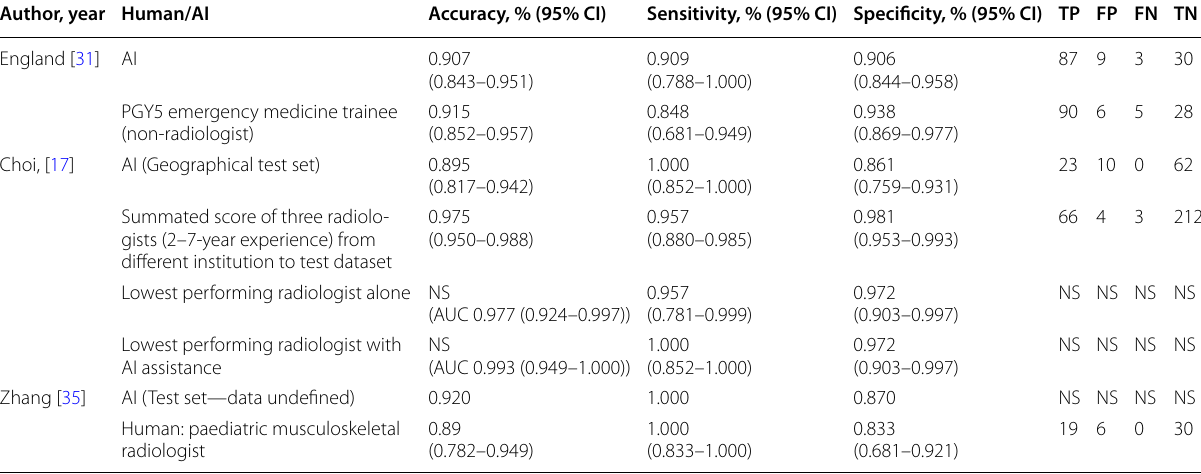
95% confidence intervals are omitted where these are not provided in the publication NS not stated. CI confidence interval. AUC area under the curve, PPV positive predictive value, NPV negative predictive value, TP true positive, FP false positive, FN false negative, TN true negative, PGY postgraduate year